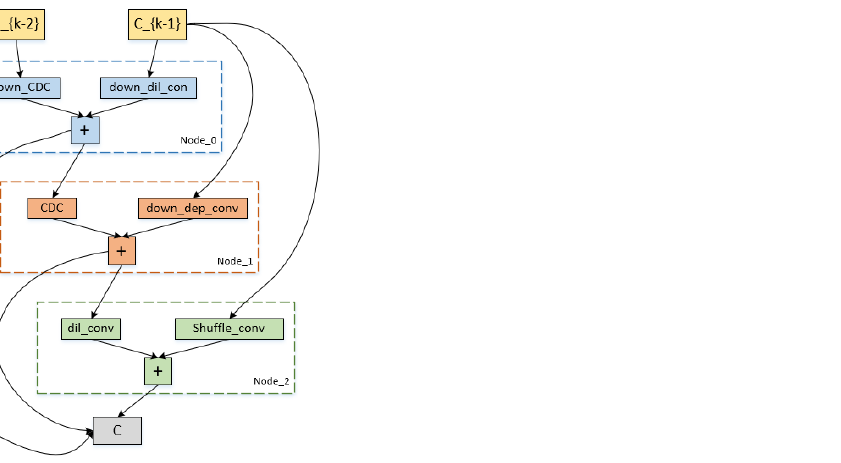
Figure 7. Cell architecture search by our method on the ISBI2015 dataset. It is the down-sampling cell